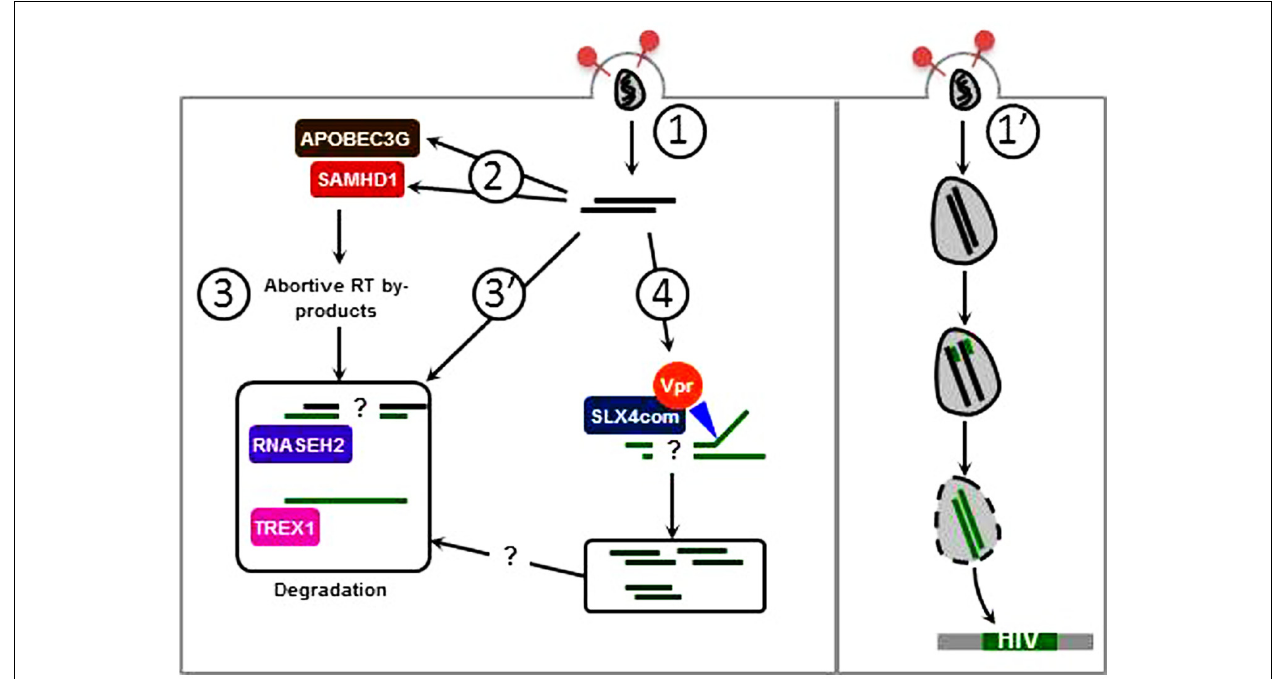
DNA:RNA hybrids whileTREX1 degrades ssDNA preferentially. (3 (cid:2) ) Abortive nucleic acid intermediates may also be directly degraded by RNaseH2 and TREX1. (4)The SLX4 structure specific endonuclease complex is activated by Vpr and likely cleaves dsDNA.Whether these dsDNA fragments are further degraded by cellular exonucleases or may be recognized by nucleic acid sensors remains questioned. (1 (cid:2) )When uncoating is correctly orchestrated, viral nucleic acids are protected from mechanisms described in 1–4, and ensures delivery of viral genomes in the